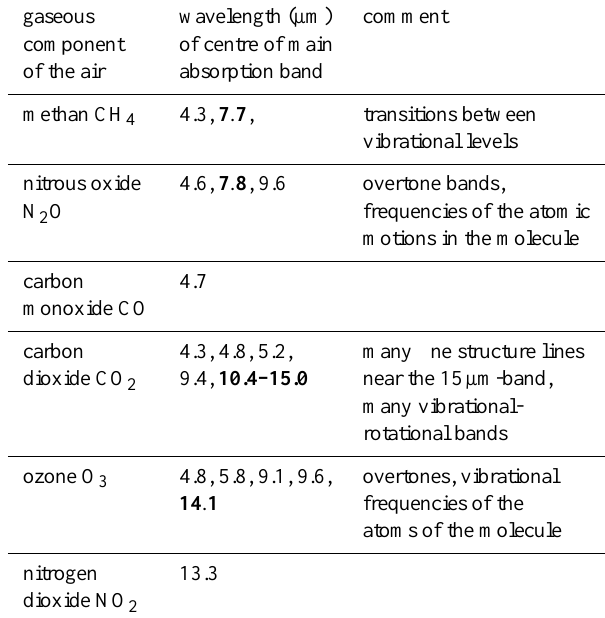
Table 1. Spectra of atmospheric gases in the IR region, which are of interest for earthquake prediction. The bold face numbers are of maximum importance for the present